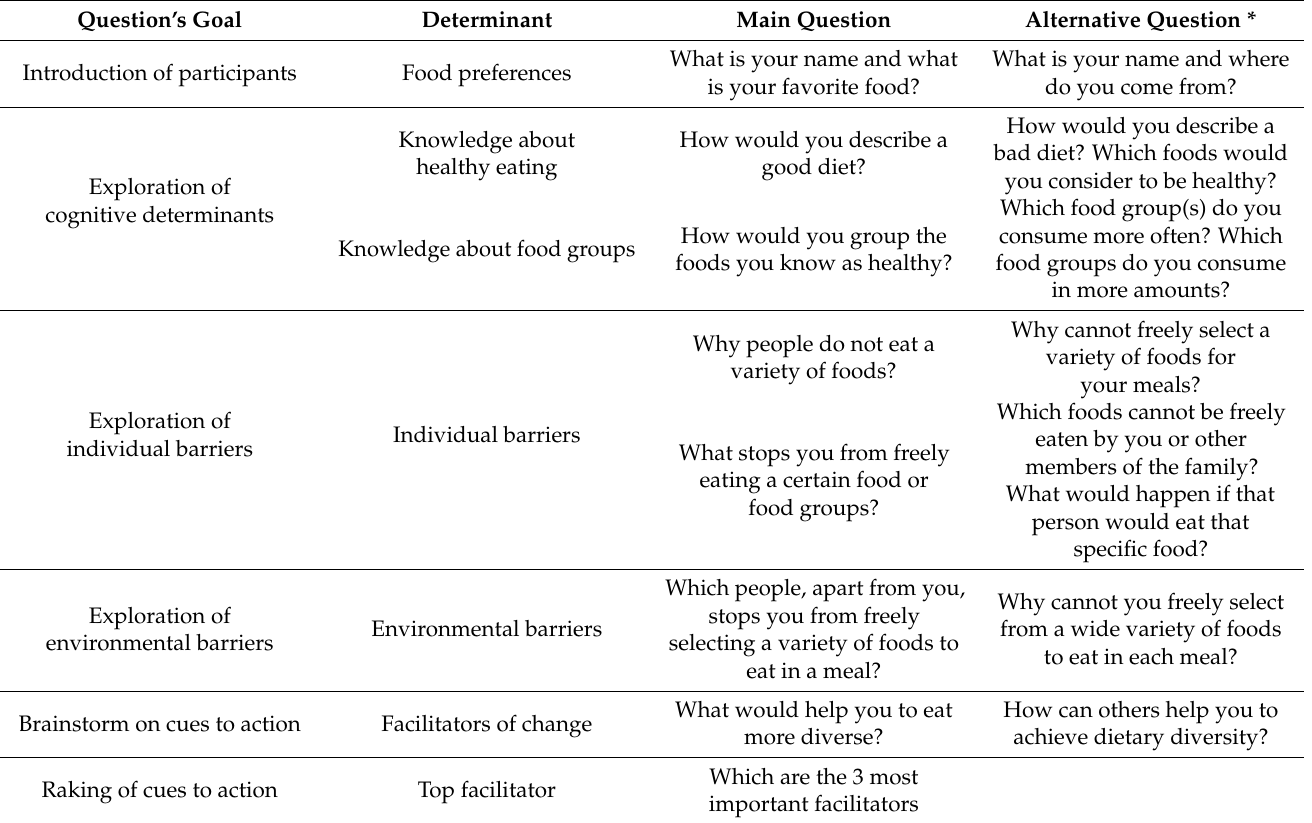
Table 2. List of questions included in the Semi Structured Questionnaire for Focus Group Discussion in Vihiga